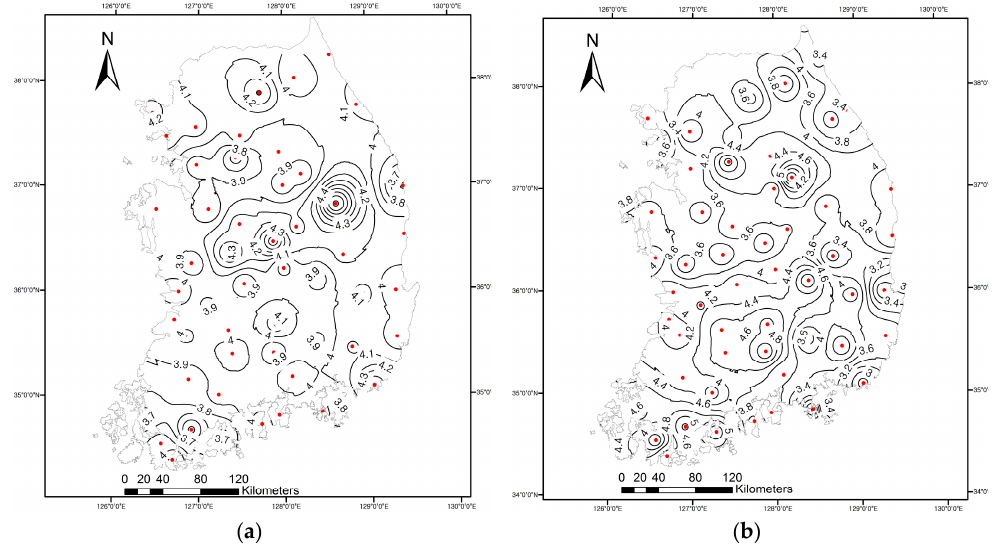
Figure 3. Spatial variability of drought characteristics from 1980 to 2015, across South Korea using SPI-6 ( a ) mean drought duration (months); ( b ) mean drought severity.